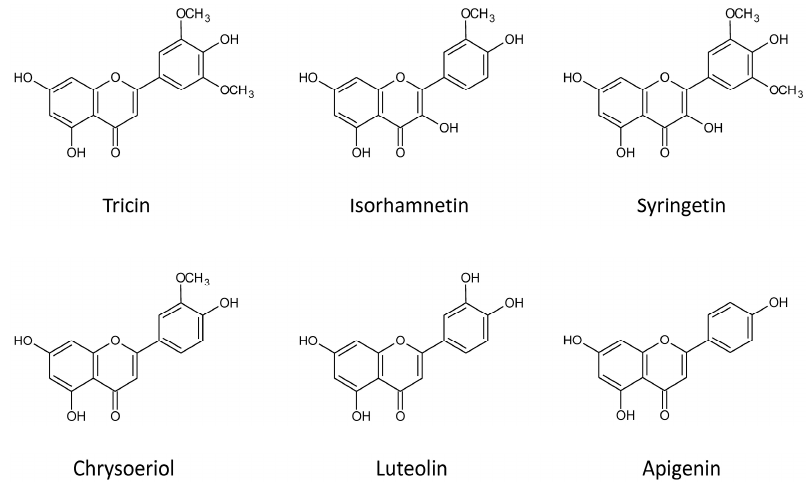
Figure 1. Structures of flavonoid aglycones identified in Axyris amaranthoides .